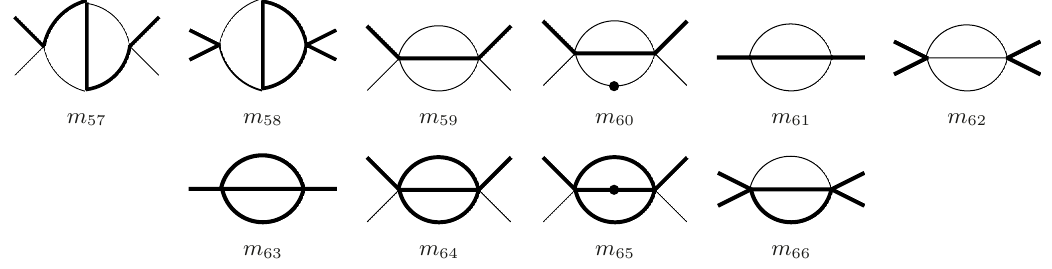
Figure 3. Two-point non-factorisable two-loop integrals. Thin lines are massless, and thick lines have mass m Q . A dot on a propagator means that the propagator is squared.